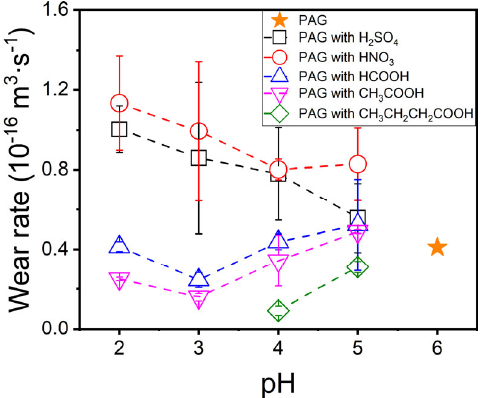
Fig. 5 Wear rate on the ball lubricated by PAG aqueous solutions with different acids at different pH values. The orange star denotes the wear rate of the original PAG aqueous solution.